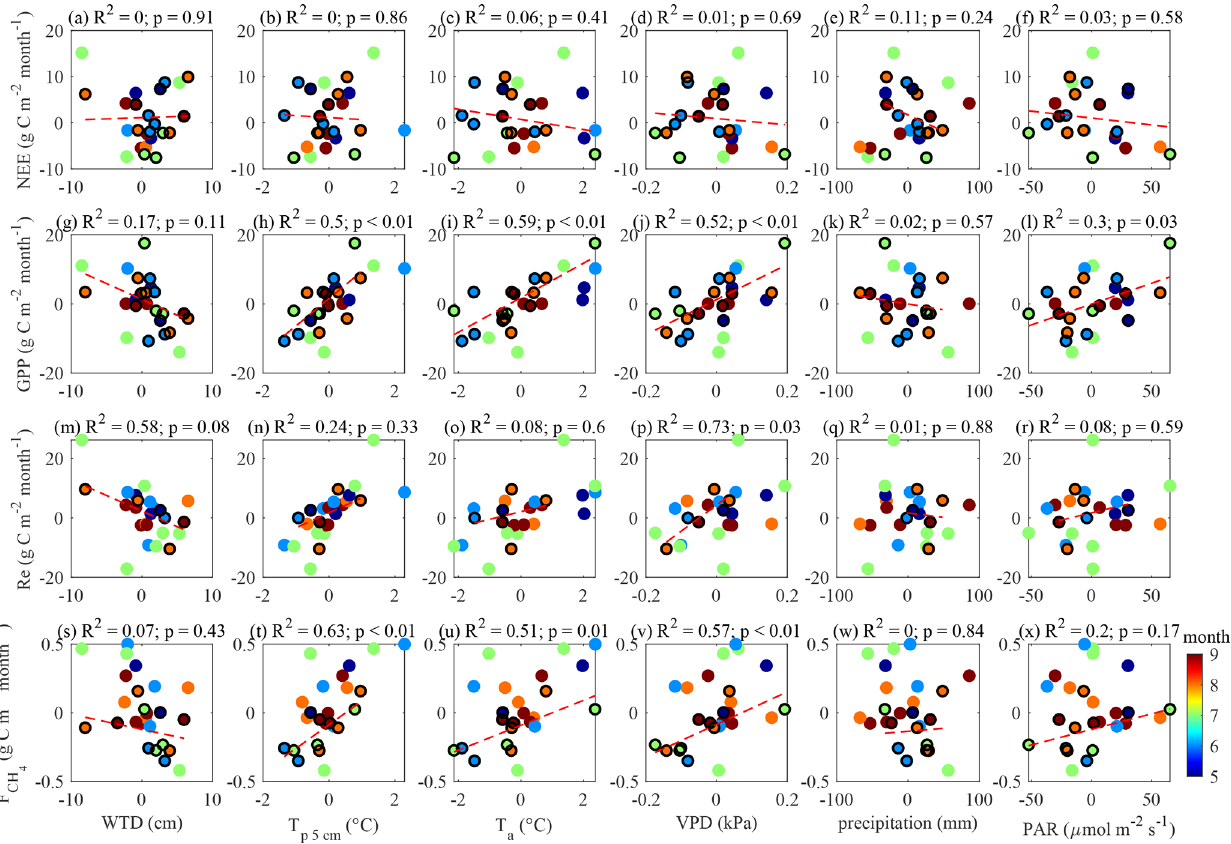
Figure B1. Monthly anomalies in May–September fluxes plotted versus the monthly means of the environmental drivers. The months with > 50% EC flux data coverage are shown with black circles and are used for linear fitting (red dash lines). Color coding shows the month number to ensure that the seasonal cycles do not influence the presented relationships.